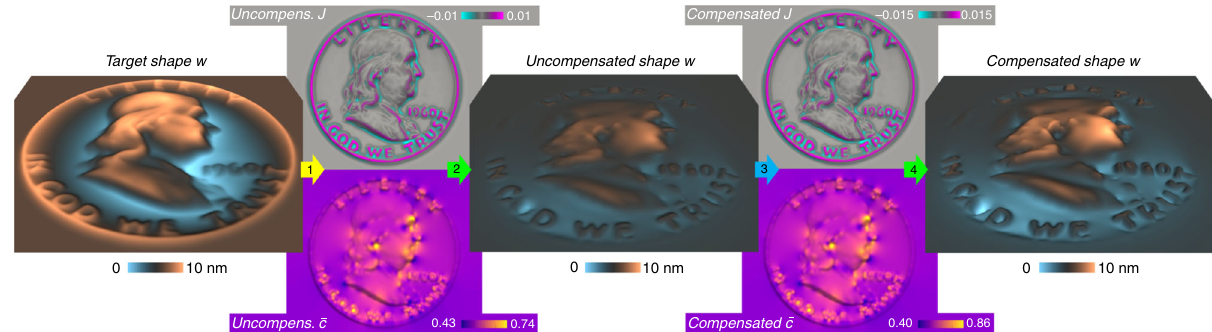
Fig. 7 Benjamin MoSeS Franklin: a complex shape produced by numerical designed composition ! shape programming. The target shape (left — a 1.4 µ m version of the obverse of the Franklin half dollar) is used as a substrate template (1) upon which an initially homogeneous MoSeS monolayer is annealed at 1023 K (shape ! composition programming, yellow arrow). (2) The resulting uncompensated composition state ( “ Uncompens. ” J and (cid:1) c ), upon release from the template yields an uncompensated shape with features very similar to the target but with smaller shape amplitude (composition ! shape programming, green arrow). (3) The composition patterns obtained from (1) are multiplied by the ratio of target (10 nm) to uncompensated (6.7 nm) shape amplitude (compensation, blue arrow). (4) A monolayer assigned the compensated composition state, upon shape equilibration yields a shape with features and amplitude very similar to the target (composition ! shape programming, green